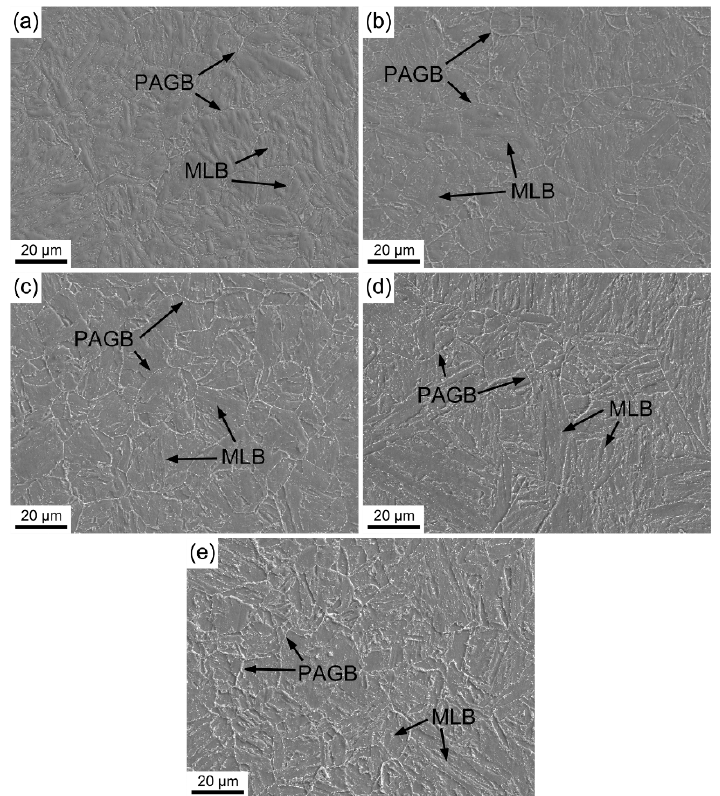
Figure 1. Scanning electron microscopy (SEM) micrographs of the T92 heat-resistant steel tempered at different temperatures: ( a ) 715 ◦ C, ( b ) 740 ◦ C, ( c ) 765 ◦ C, ( d ) 790 ◦ C, and ( e ) 815 ◦ C. Table 2. Grain size of the T92 heat-resistant steels tempered at different temperatures.